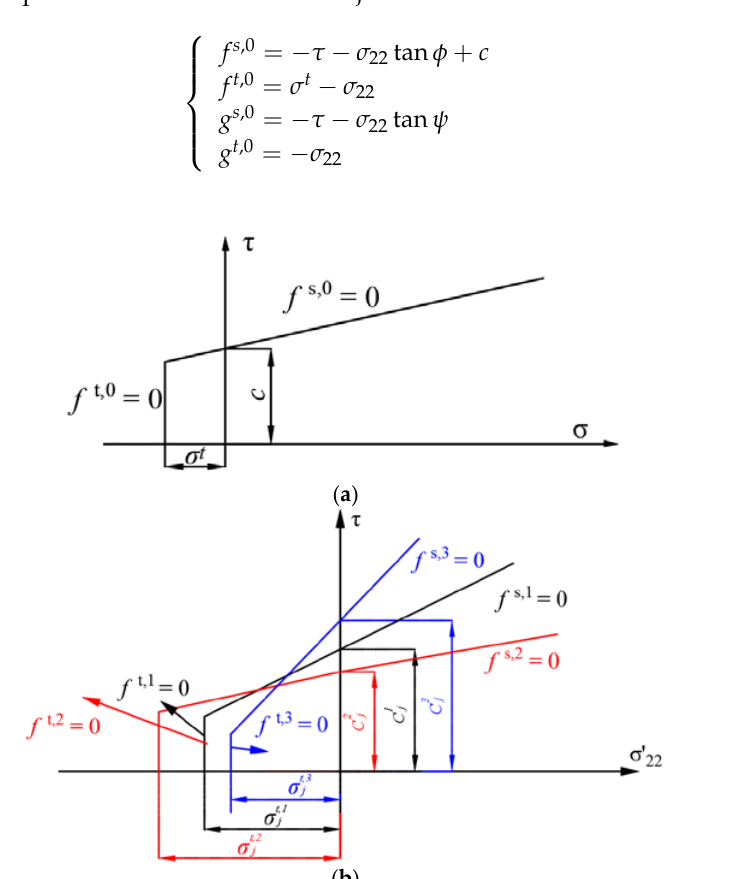
Figure 11. ( a ) Illustration of the intact rock failure criterion; ( b ) Three joint failure criteria in a multi-joint model.